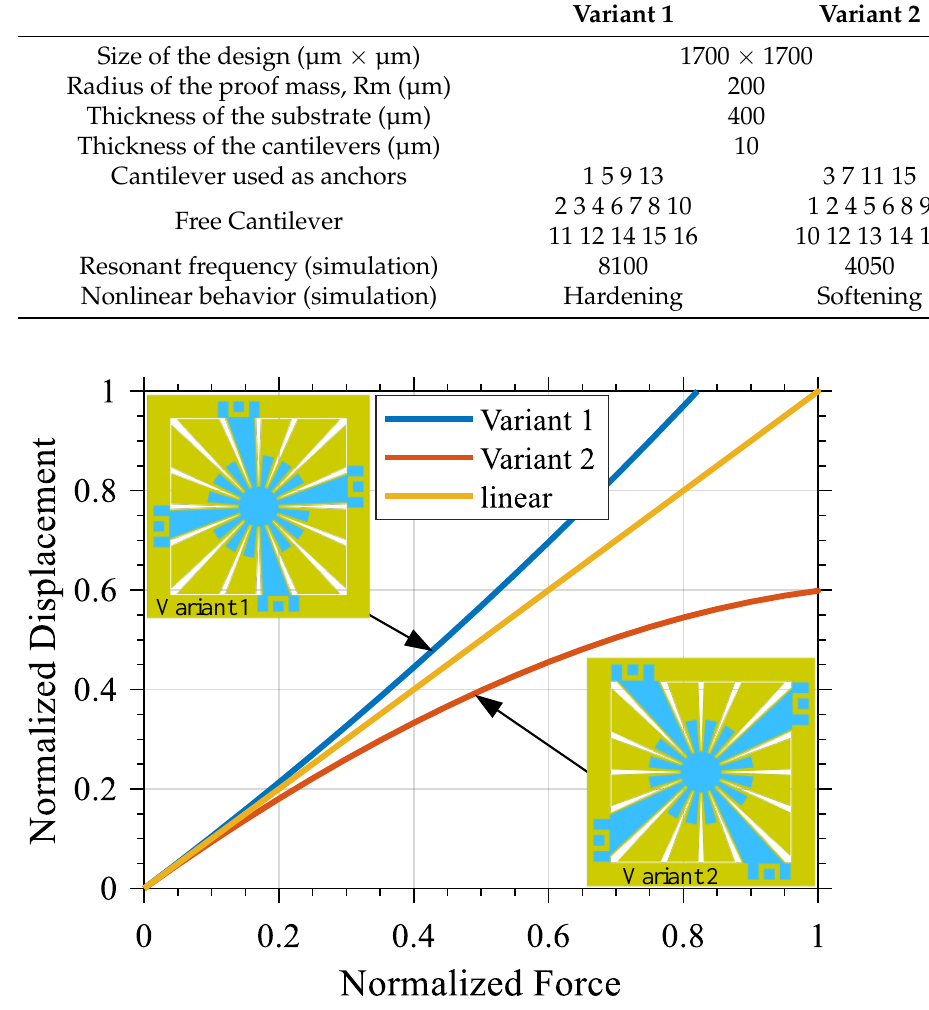
Figure 3. Influence of the force applied on the deflection of the central proof mass for both SD resonator